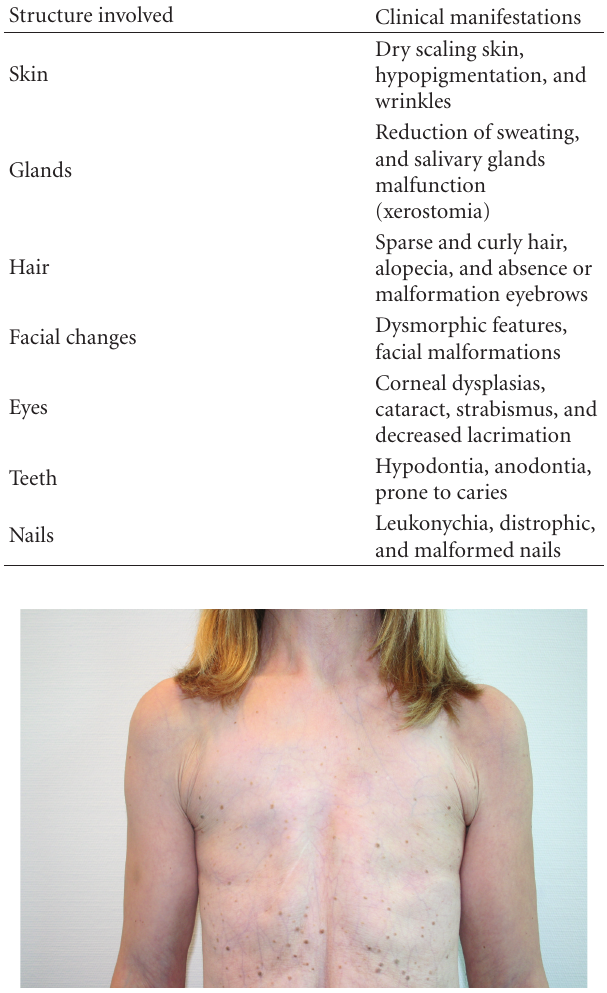
Figure 1: Preoperative frontal view, showing complete amastia with the presence of a hint of bilateral nipples.